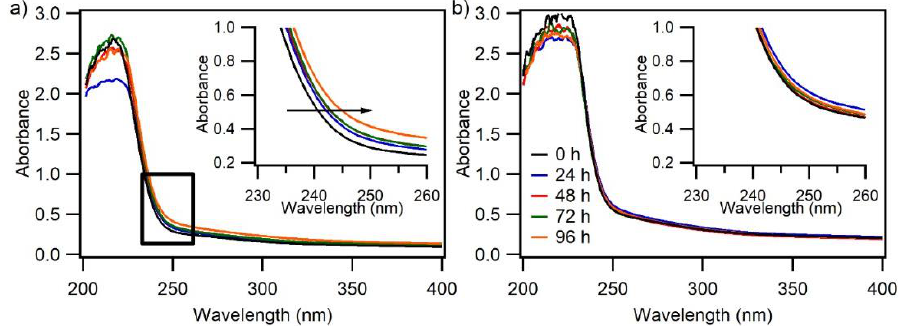
Figure 8. UV–VIS spectra of ( a ) PBSA and ( b ) PBSA 8 wt% nanocomposite films after being irradiated in the accelerated photo-aging chamber (SEPAP 12–24) for up to 96 h. The evolution of UV-absorbing character of the aged films over time is highlighted in the inserted graphs. All the spectra have been baseline corrected.